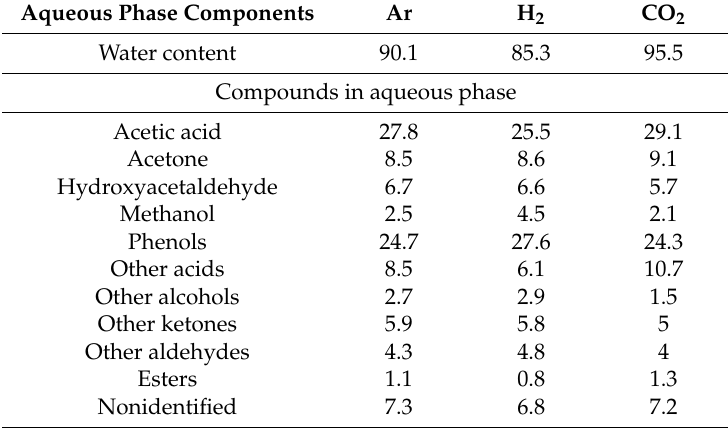
Table 2. Summary of the composition of liquid products (wt %) collected from the thermal decomposition of kraft lignin under three different atmospheres.